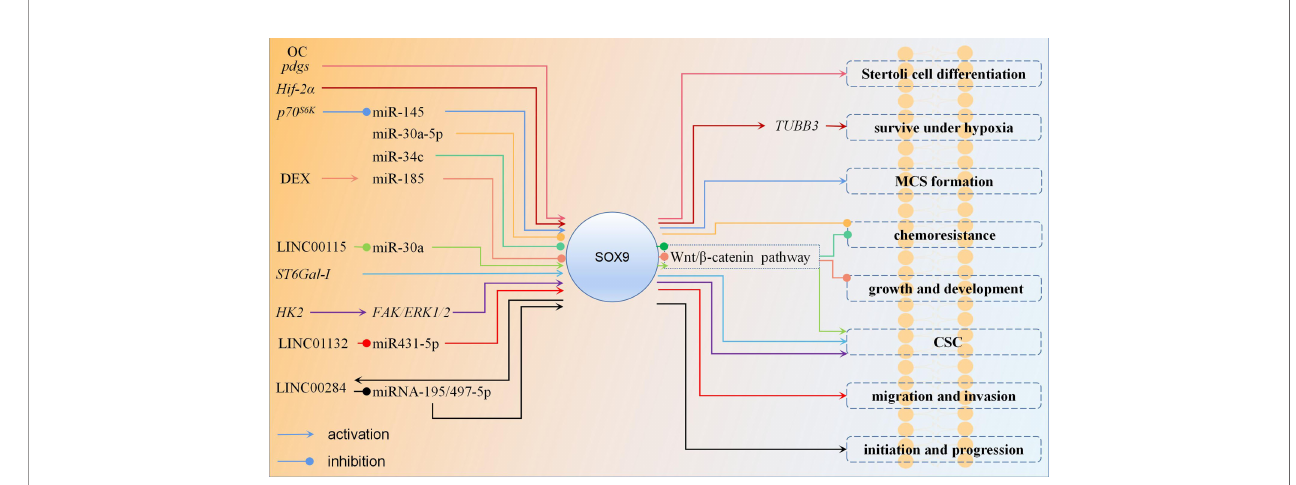
FIGURE 2 | The regulation mechanism of SOX9 in ovarian cancer. In most studies of ovarian cancer, SOX9 plays an oncogene role. Upregulation of SOX9 expression promotes Stertoli cell differentiation, ovarian cancer cell survival under hypoxia, MCS formation, chemoresistance, growth, development, CSC stemness, migration, invasion, initiation and progression. Promoting the expression of certain miRNAs can inhibit the expression of SOX9 and thus suppress ovarian cancer. Wnt/ b -catenin pathway is also an important pathway, and downregulation of SOX9 expression can inhibit it then suppress ovarian cancer chemoresistance, growth, development, CSC stemness. Each color represent a regulation mechanism of SOX9